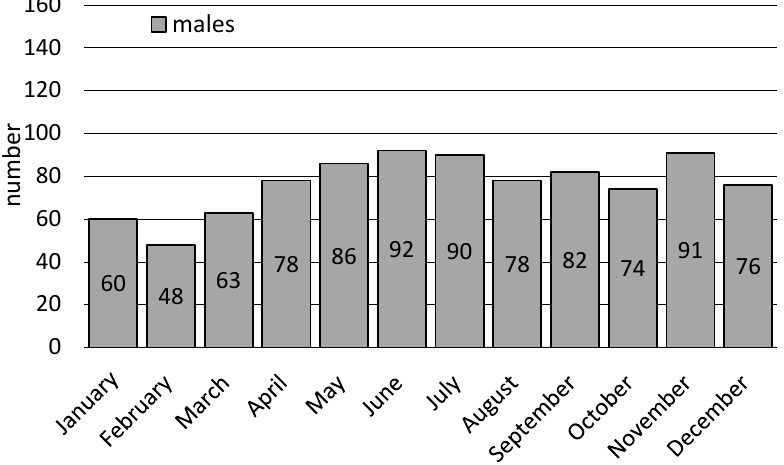
Figure 3. Interventions of emergency medical services teams in the workplace depending on month and the patient’s gender.